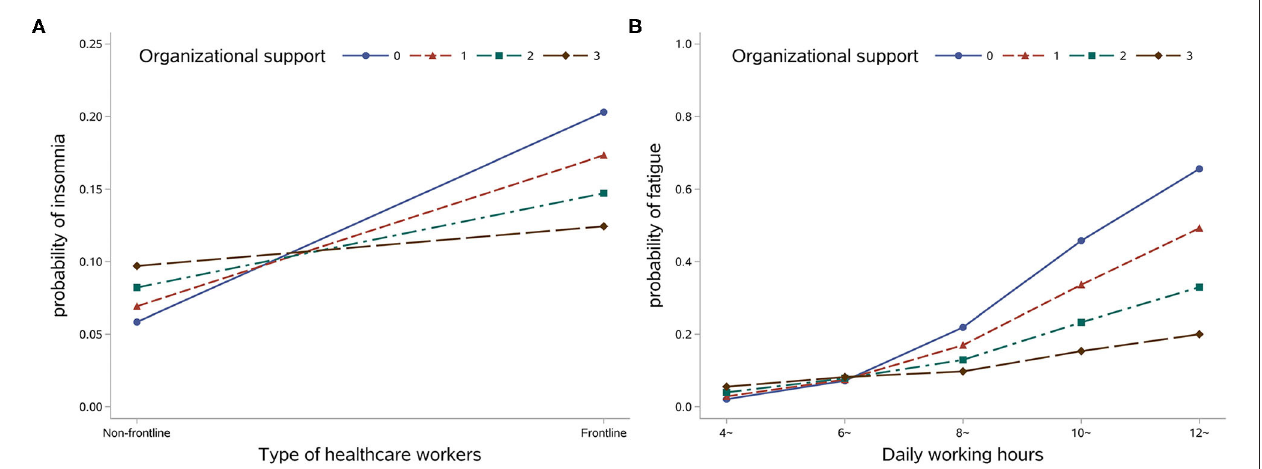
FIGURE 1 | Predicted probability of insomnia among different types of healthcare worker by organizational support level (A) and predicted probability of moderate to high degree of fatigue among different types of healthcare worker by organizational support level (B) .